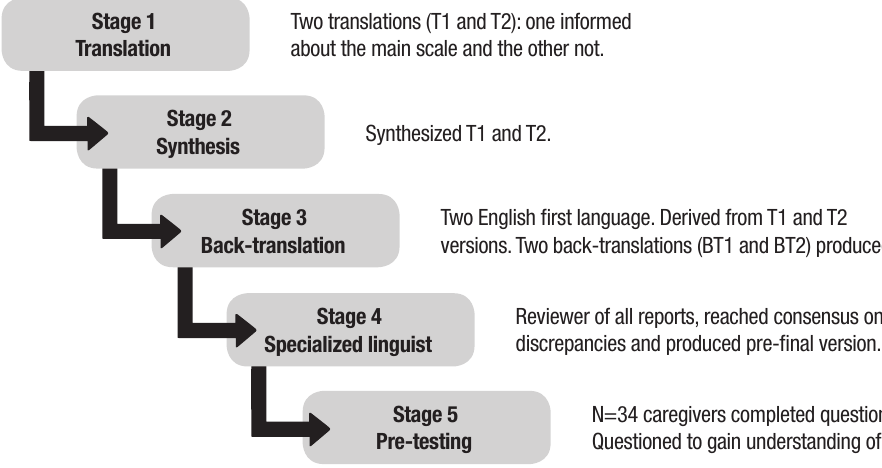
Figure 1. Graphic representing stages of the cross-cultural